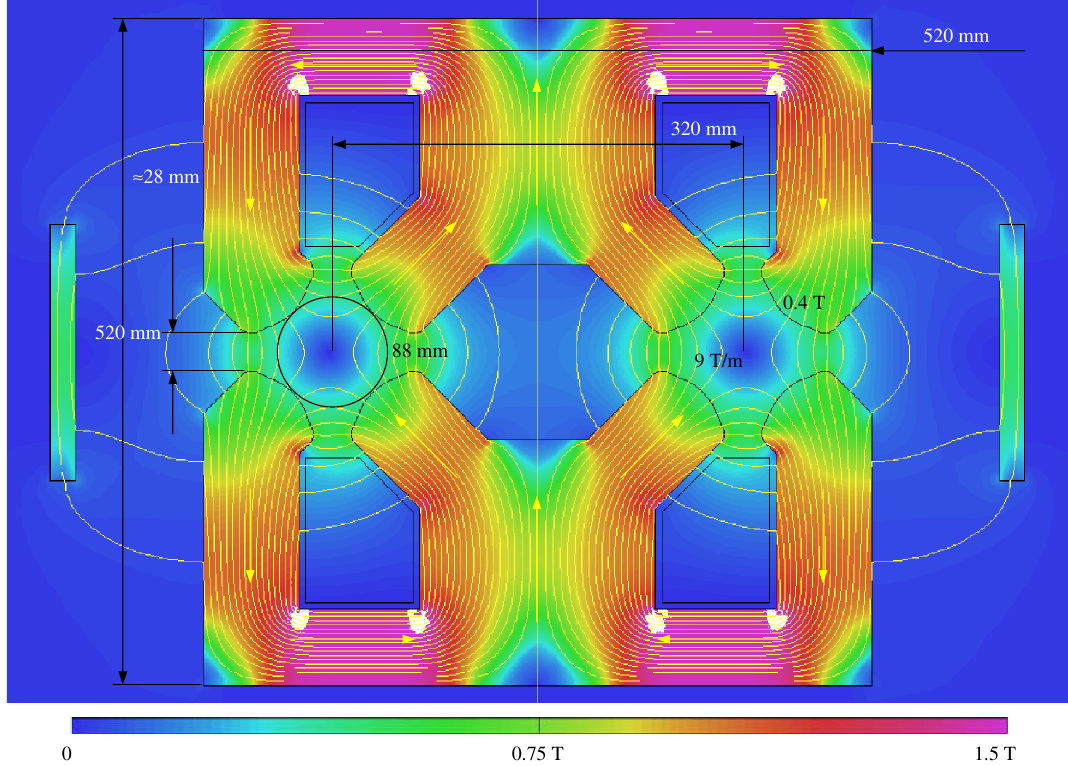
FIG. 7. First cross section of FCC-ee twin quadrupoles; the geometry is to scale with the twin dipole of Fig. 6 (field levels for 175